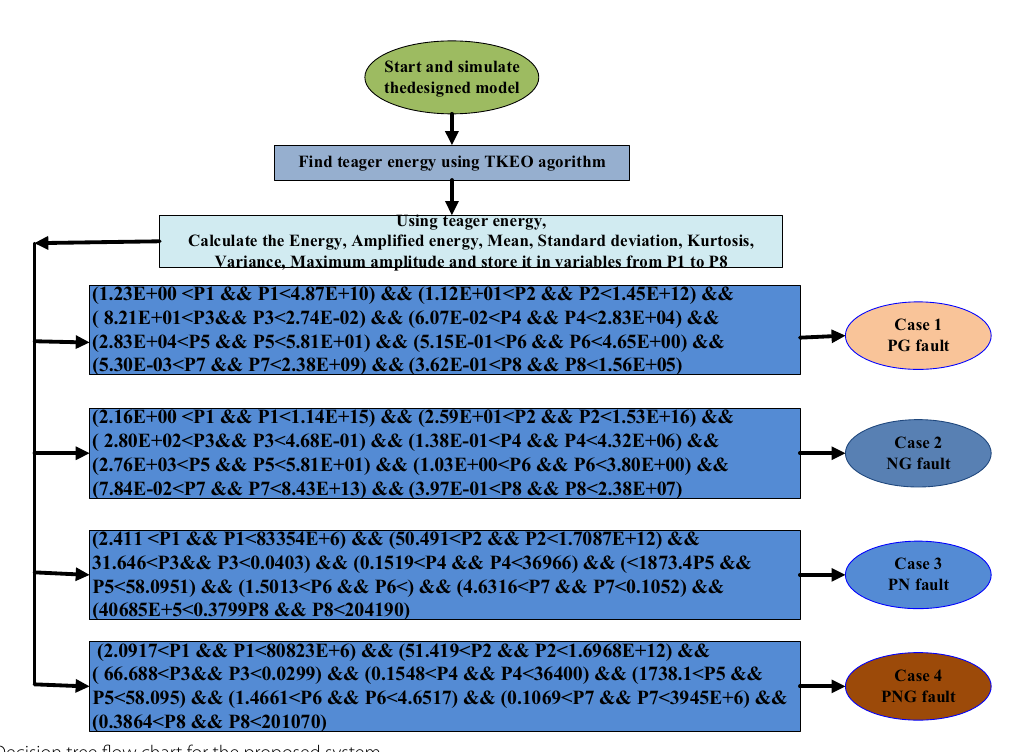
Fig. 16 Decision tree flow chart for the proposed system